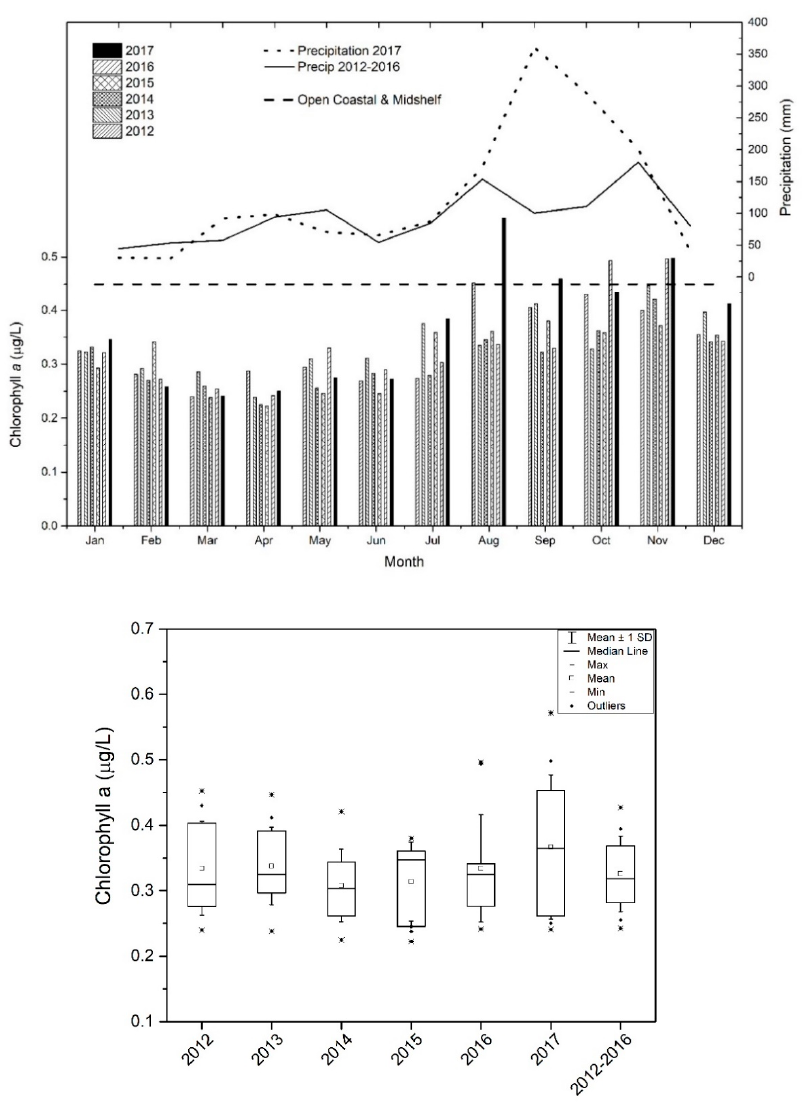
Figure 6. Monthly comparison of the Chl- a concentration for all regions ( µ g / L) showing the yearly distribution from 2012–2017 with associated precipitation data (top). The year 2017 is filled in black. The dashed line for 0.45 µ g / L represents the chlorophyll threshold for open coastal and mid-shelf waters [23]. (Bottom) Box plot showing yearly statistics of the Chl- a concentration for all regions.